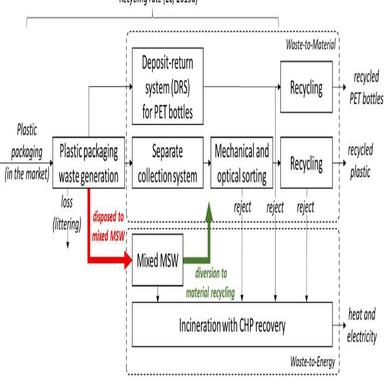
Waste management system for plastic packaging in the Swedish case city. Potential increase in the overall recycling rate is shown by diverting the plastic packaging loss in mixed MSW from waste-to-energy to waste-to-material recycling.